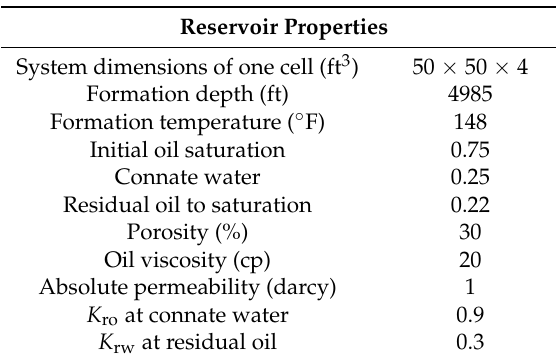
Table 1. Description of the reservoir properties.